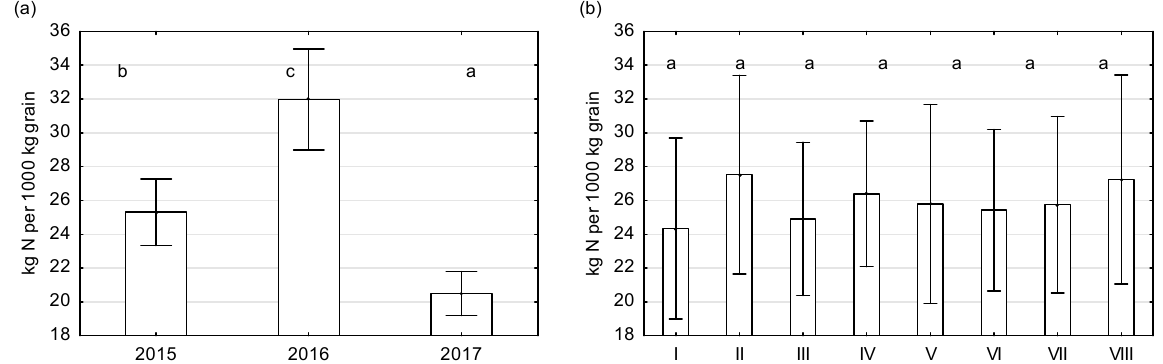
Figure 4. N uptake by the yield of 1000 kg of grain (RIE) including the appropriate amount of straw depending on the year of research ( a ) and fertilization ( b )—mean ± SE; figure ( a ) years of experiment (2015, 2016 and 2017), figure ( b ) number of object (I–VIII)—see Table 1. The average share of grain in N accumulation (HI N ) in the second year of the experi- ment was significantly lower (around 47%) than in the first and third years of the study (62 and 61%, respectively) (Figure 5a). The tested fertilization had no significant effect on the value of the HI N (Figure 5b). The HI N varied from approximately 55% (maize fertilized before sowing and then top-dressing with UAN, and maize treated with UAN + P (Starter) prior to sowing and with UAN + Mg applied as a top-dressing treatment) to about 60% after pre-sowing and top-dressing applications of UAN + P (Medium).